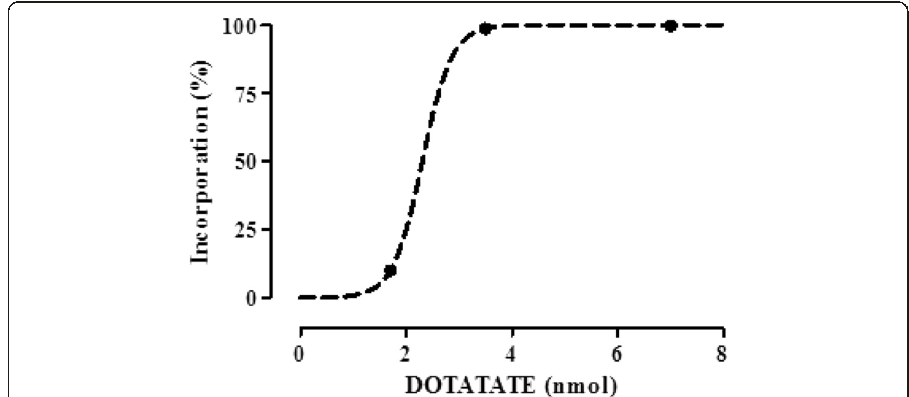
Fig. 2 The incorporation (%) of 213 Bi-DOTATATE 71 ± 28 MBq determined by ITLC analysis as function of peptide amount in a reaction volume of 800 μ L. An S-shaped cureve has been fitted through the data with an incorporation of 50 % at 2.4 ± 0.09 nmol and a slope of 0.25 ± 0.03 nmol peptide, n ≥